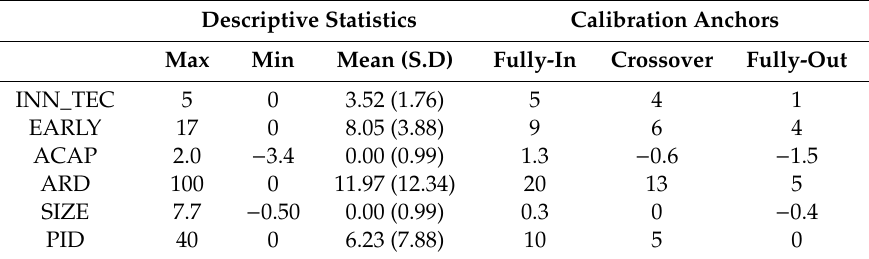
Table 3. Main calibration points and summary of the descriptive